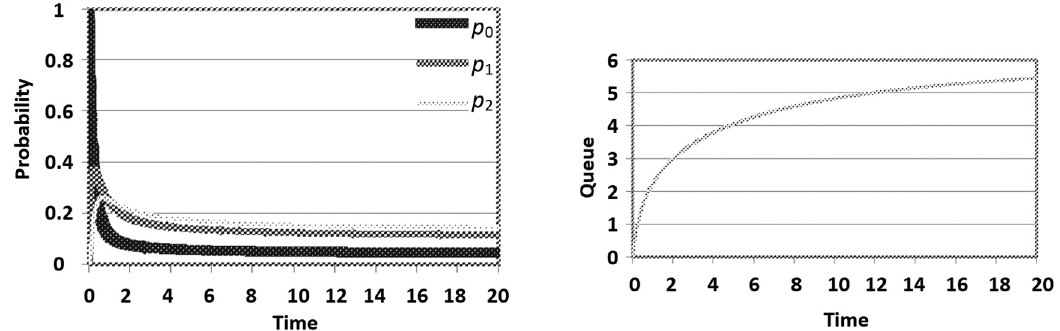
Figure 1: ( ) ( ) / / M τ M τ 3 queue with constant parameters: ( ) = μ τ 2 , and ( ) = λ τ 5 .